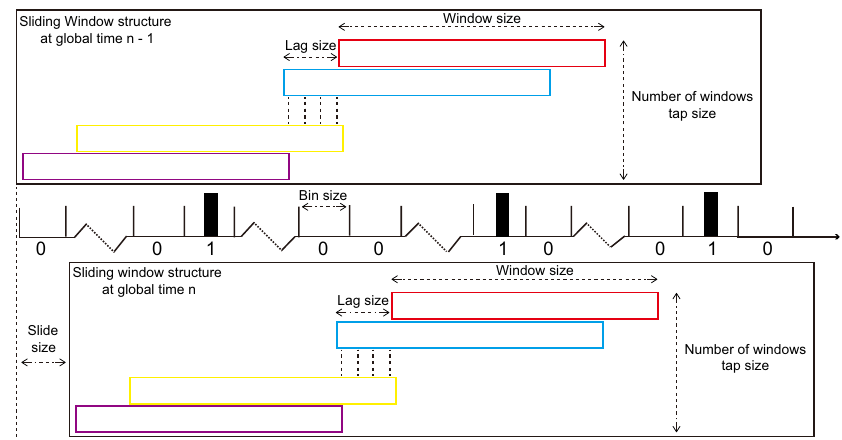
Figure 4. Sliding window structure. We bin the neural spikes into 5 or 10 ms bin size in which there is only one or none spike. The window size is the length of the sliding window. The tap size is the number of slide windows. The lag size is the time lag between consecutive slide windows. The slide size is how long we move in the timeline of the whole sliding window structure from global time instant n-1 to global time instant n. The slide size is equal to the bin size in our paper, we move 1 bin at a